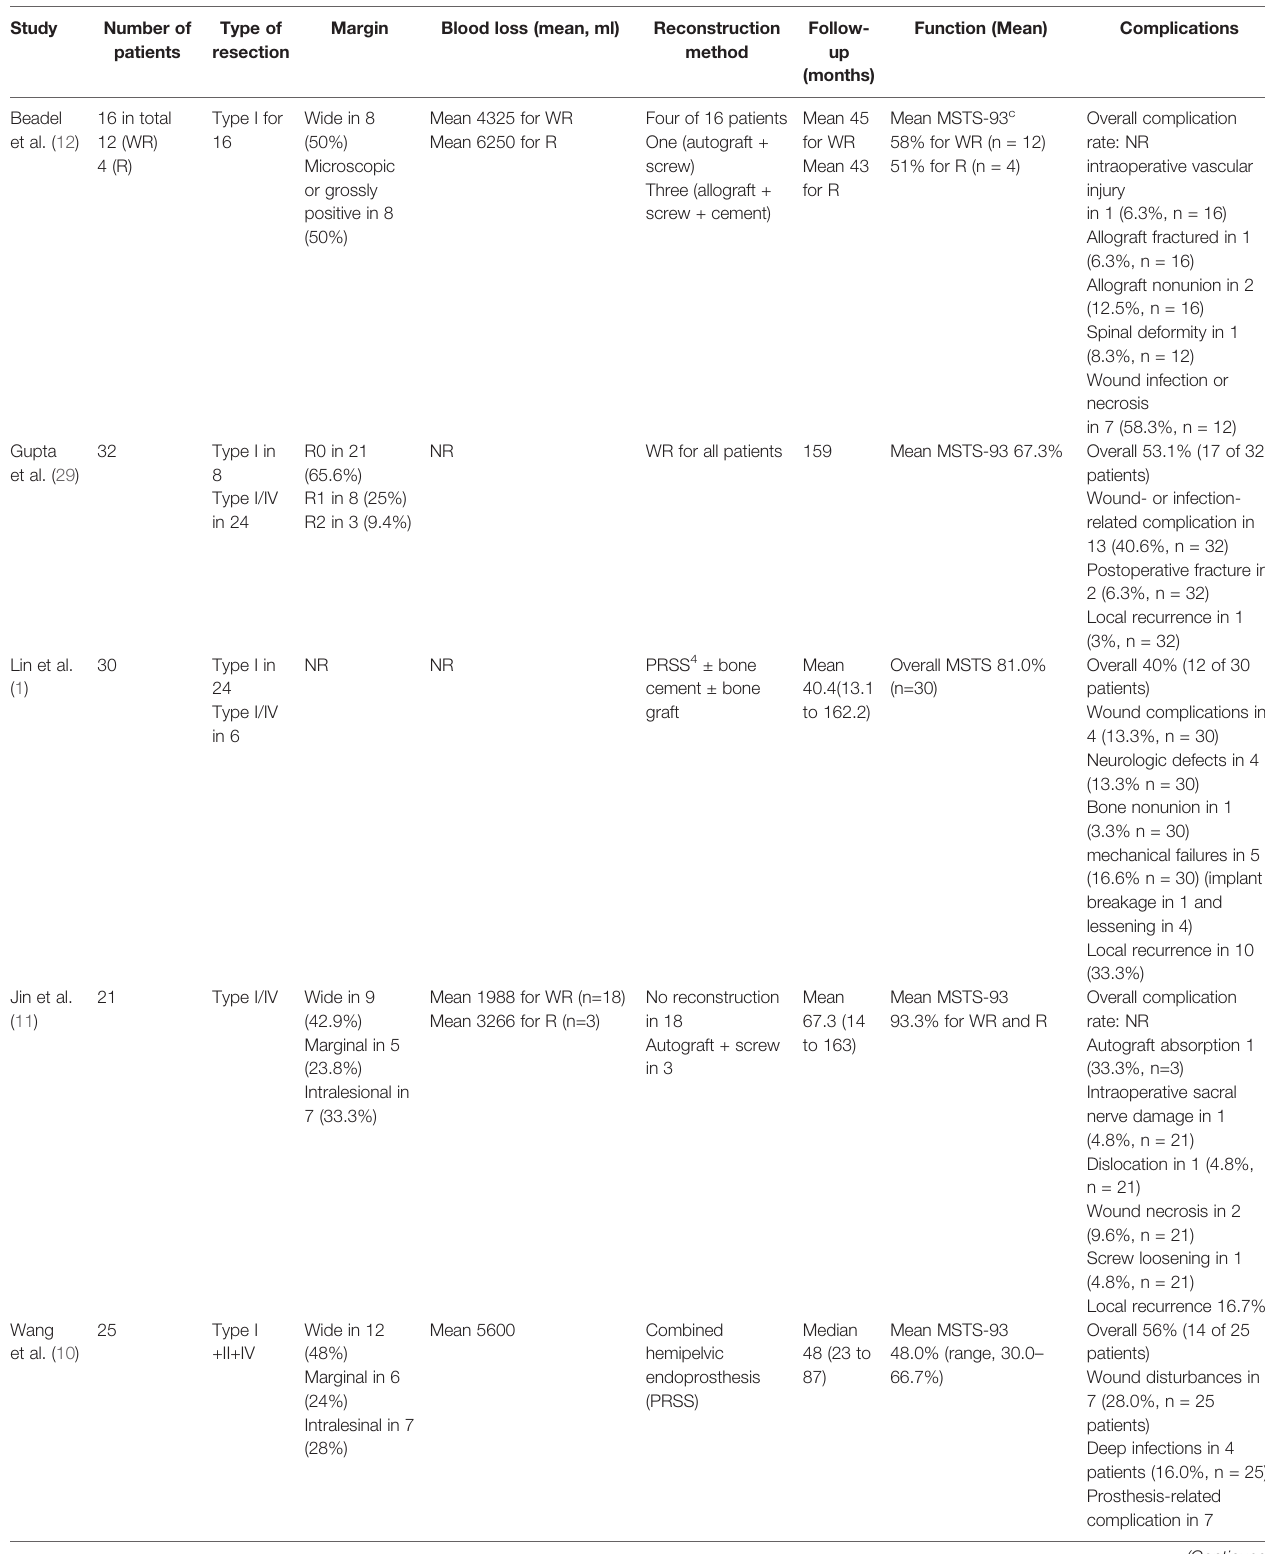
TABLE 3 | A review of previous studies on sacroiliac resection and reconstruction, the margin, blood loss, proportion of patients with complications, and functional